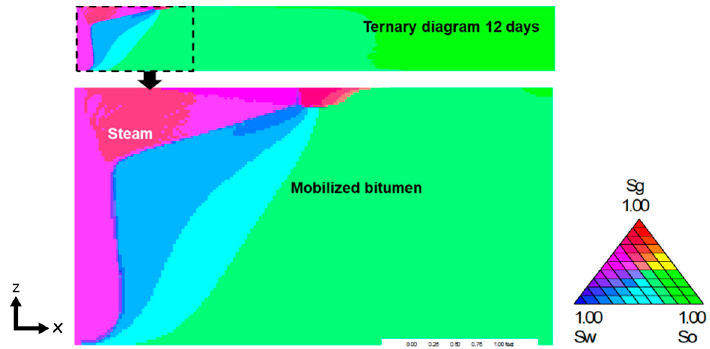
Figure 13. Cross section of the ternary diagram for the HE model. A section of the 2D image indicated by black dashed square has been zoomed in.